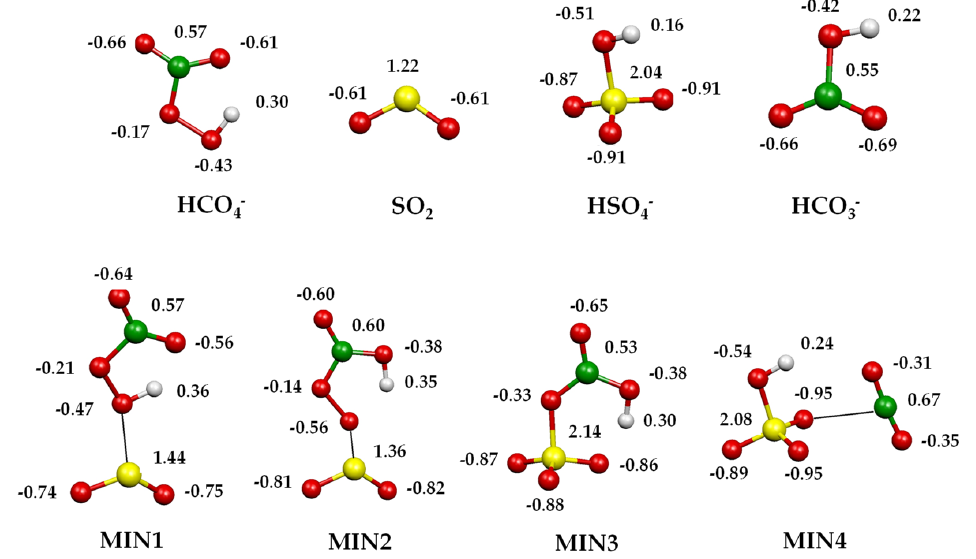
Figure 4. Schematic energy diagram of the reaction of HCO 4 ‐ ions with SO 2 . Geometries of the minima localised on the [HCO 4 ∙∙∙ SO 2 ] − potential energy surface optimised at the B3LYP/aug ‐ cc ‐ pV(T+d)Z level of theory. Bond lengths in Å, angles in degrees, Δ H° values in kcal mol − 1 computed at the CCSD(T)/aug ‐ cc ‐ pV(T+d)Z level of theory.